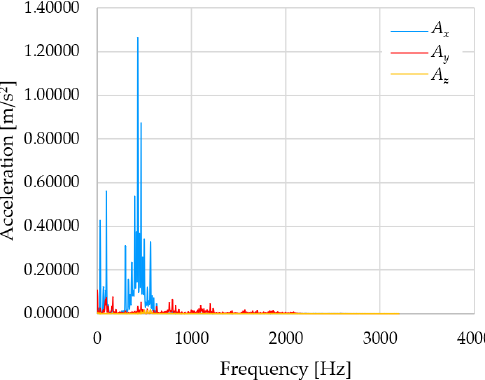
Figure 11. Acceleration progress depending on frequency in X- , Y- and Z -axes for velocity 100% (131.0°/s).